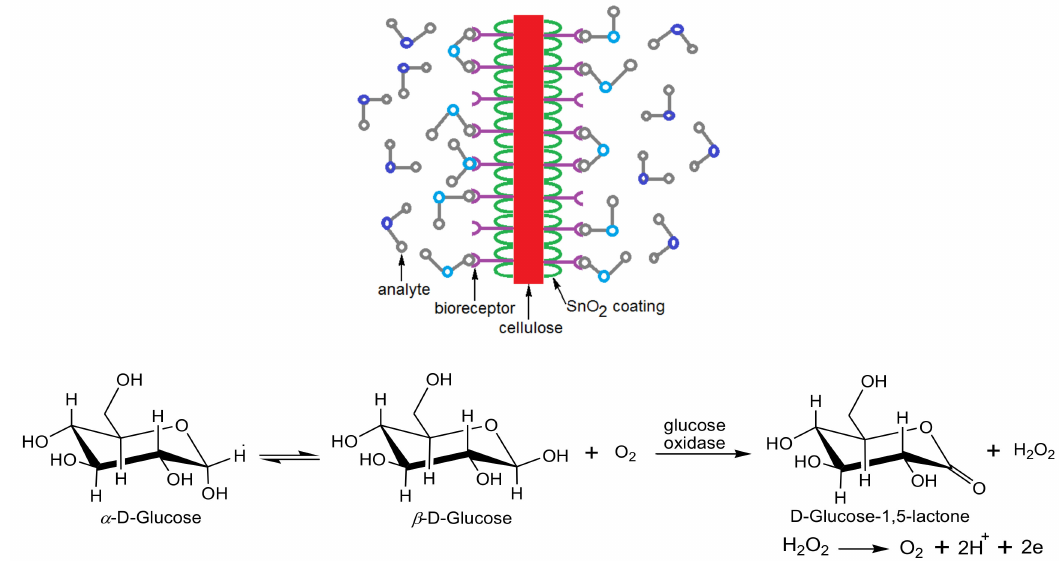
Figure 11. Conductometric glucose biosensor (top) and the sensing reaction mechanism